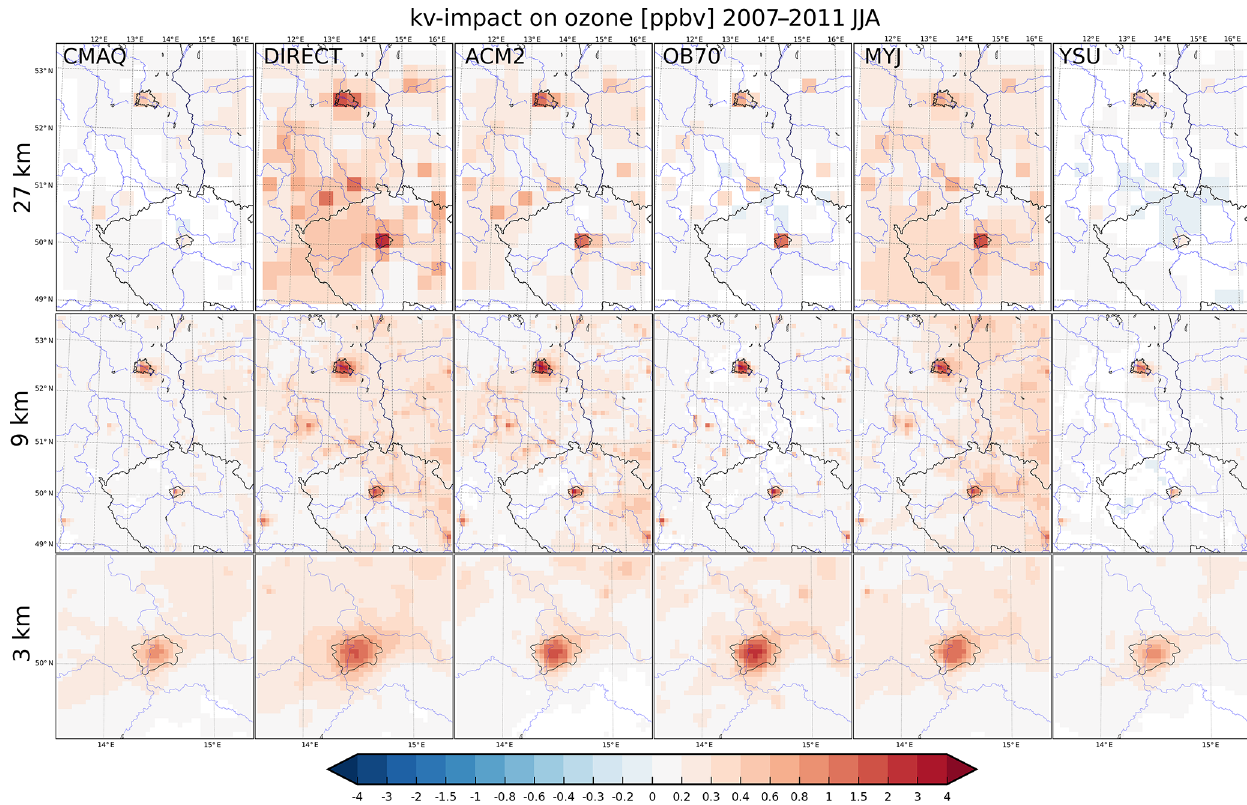
Figure 18. The impact of urbanization-induced K v enhancement (i.e., increase of vertical eddy diffusivity) on surface O 3 concentrations in ppbv for the 27, 9 and 3km resolutions (top to bottom) for JJA for the six K v methods (CMAQ, DIRECT, ACM2, OB70, MYJ and YSU). The geographic locations of Berlin and Prague are indicated by their administrative boundaries. Shaded areas represent statistically significant changes on the 98% level using a two-tailed t